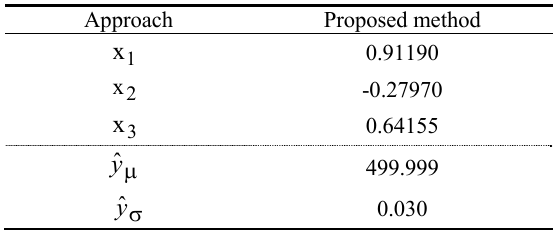
Table 8. The optimal solution for the printing ink problem with improved modeling by Das [34]